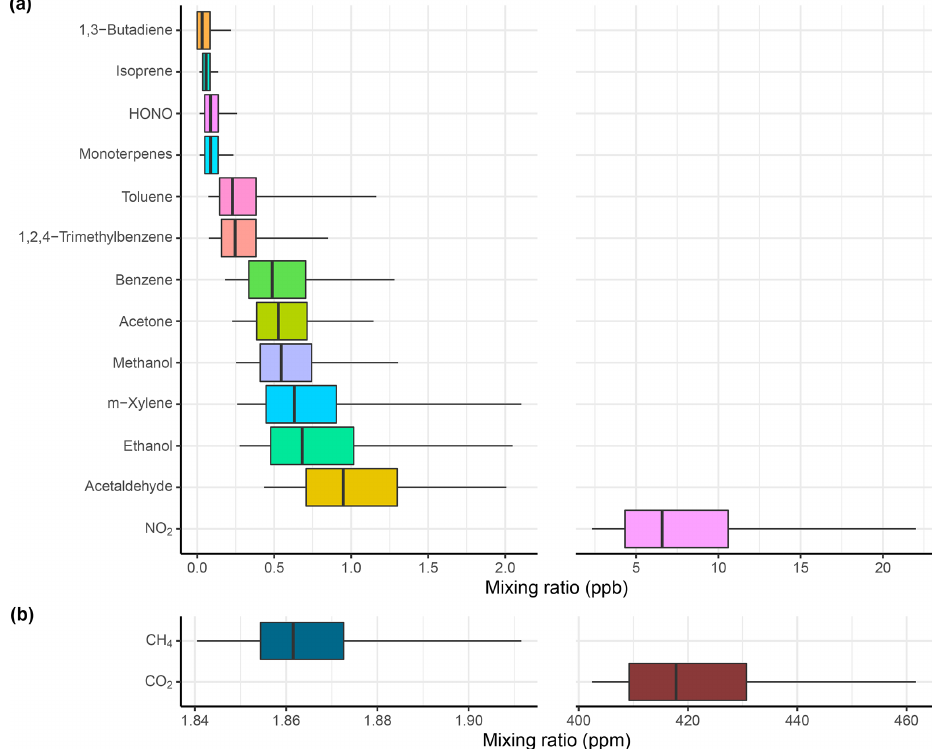
Figure 6. Summary of measurements made by (a) the SIFT-MS (in ppb) and (b) the UGGA (in ppm) during 30 repeat drives around York. The box outline contains the 25th to the 75th percentile, and the middle line shows the median mixing ratio for each compound. The whiskers represent the 5th and 95th percentile for the mixing ratios of each compound. It is worth noting that NO 2 and CO 2 are on individual scales due to differing ranges in their mixing